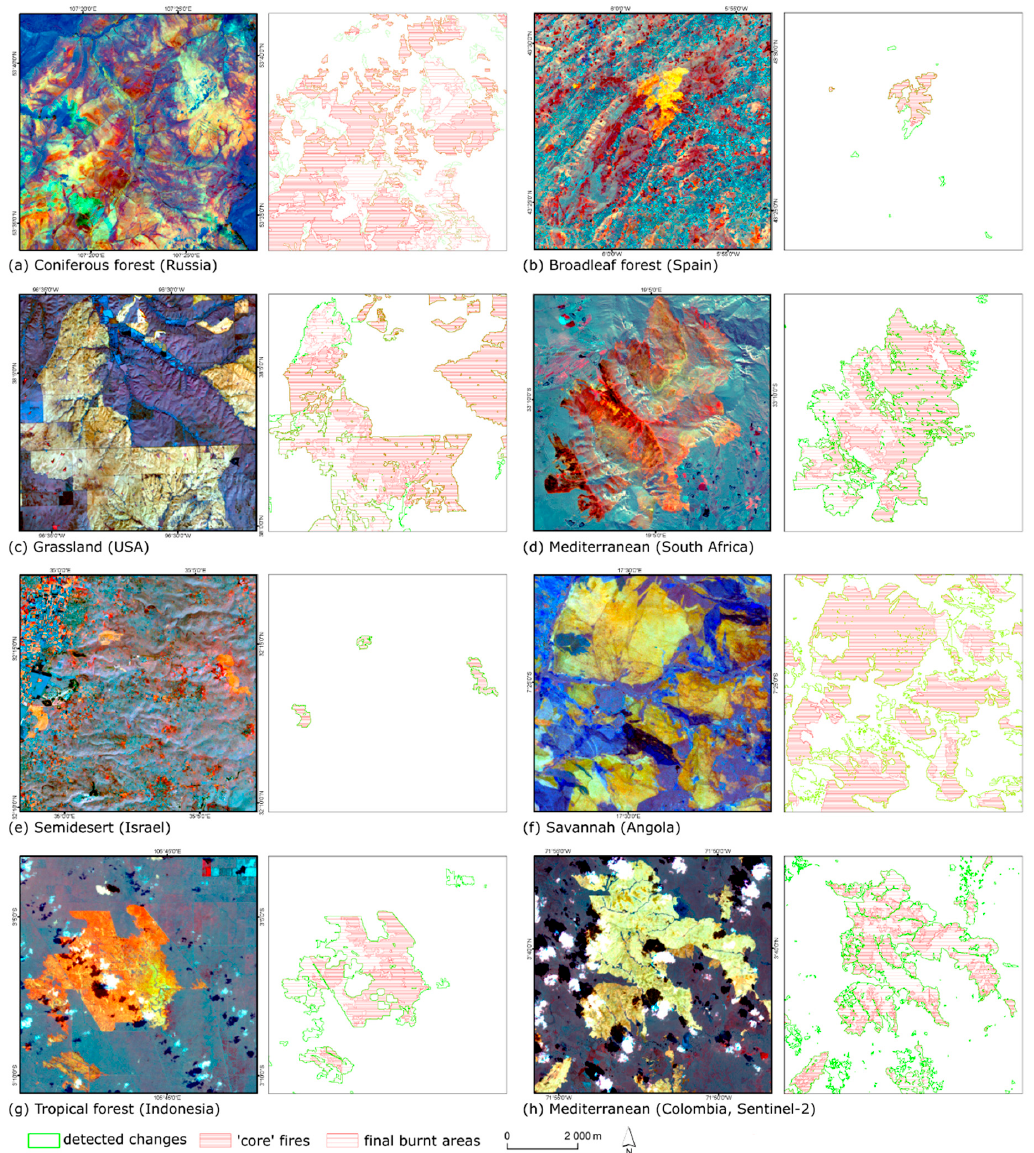
Figure 4. Examples of burnt area mapping in different geographic zones and vegetation types.